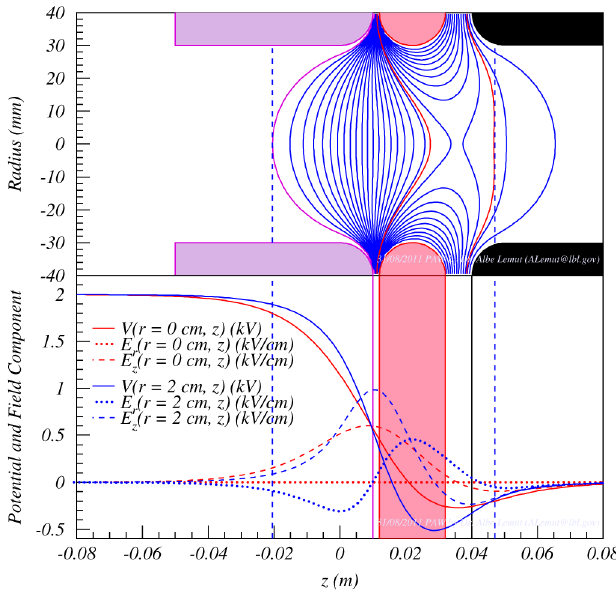
FIG. 8. Top: Potential for a 2 kV postacceleration voltage, (cid:1) 1 : 3 kV screening voltage, 2 mm gap width. Bottom: Voltage, for potential shown on top, along the center line (solid blue line) and radius 2 cm (solid red line) trajectories. The radial E r (dotted lines) and axial E z (dashed lines) electric field components are also shown. The magenta vertical line represents the high- voltage electrode tip, the red area the screen electrode extension, and the black vertical line the ground electrode tip (see top figure). The blue vertical lines represent the points where the axial voltage is 1.8 kV and (cid:1) 200 V . The space-charge length is 67.6 mm. The z coordinate is the same as Fig.